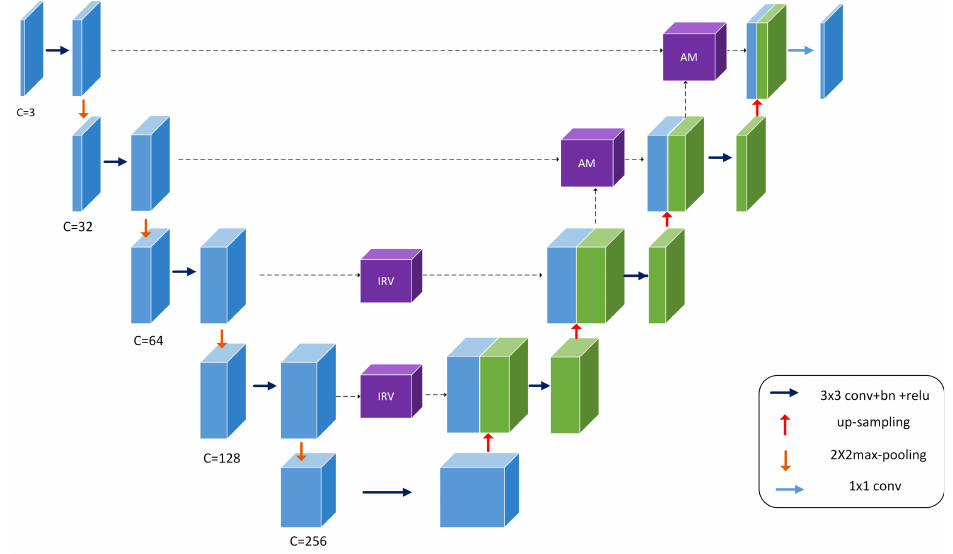
Figure 1. Overview of the proposed MIU-net